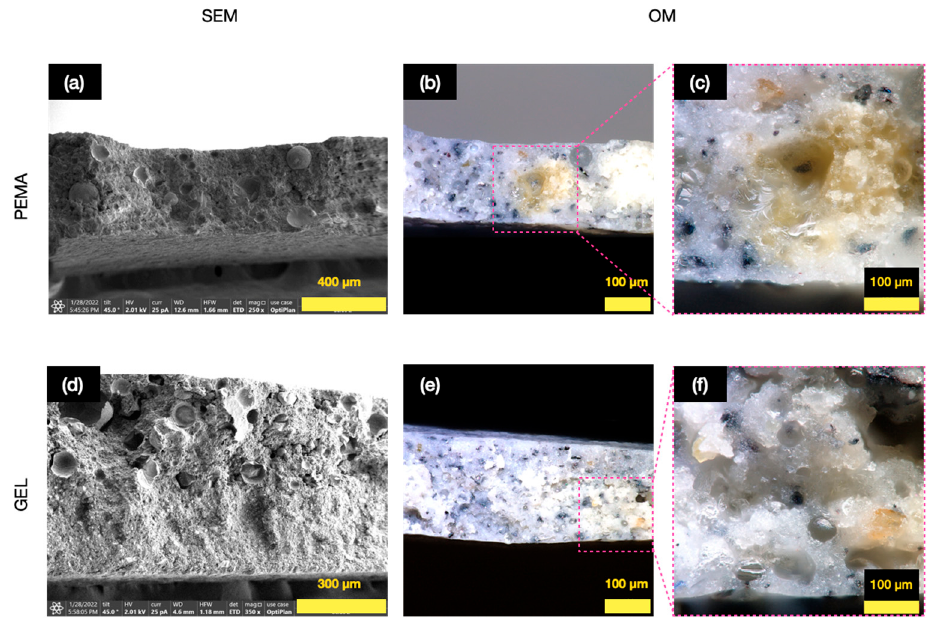
Figure 9. Cross-sectional images of ( a ) SEM image of 5 wt. % PEMA microcapsules primer dispersion, ( b ) OM of the 5 wt. % PEMA microcapsules primer dispersion, ( c ) closer observation of the OM for the 5 wt. % PEMA microcapsules primer dispersion, ( d ) SEM image of 5 wt. % GEL microcapsules primer dispersion, ( e ) OM of the 5 wt. % GEL microcapsules primer dispersion, ( f ) closer observation of the OM for the 5 wt. % GEL microcapsules primer dispersion.